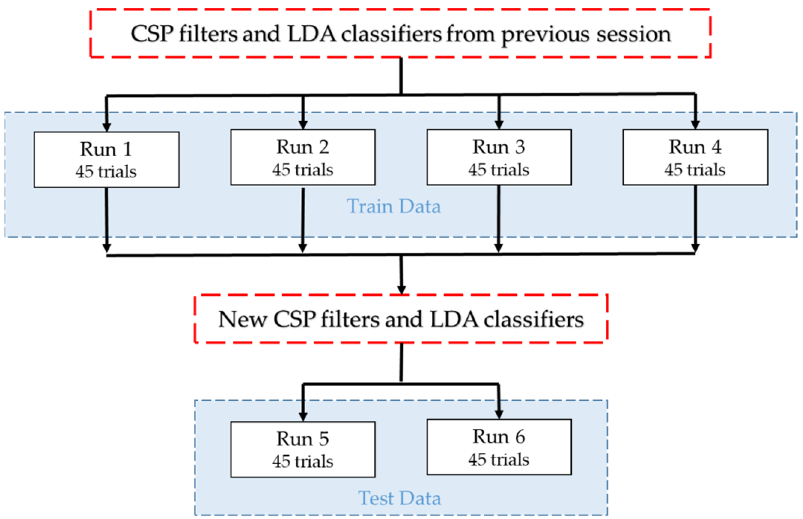
Figure 3. Flow diagram of one session: training data (run1–4) are recorded by using CSP filters and the classifier from the previous session. Training data was used to generate new CSP filters and a classifier. Test data (run5, 6) were recorded by using new filters and a classifier [34].